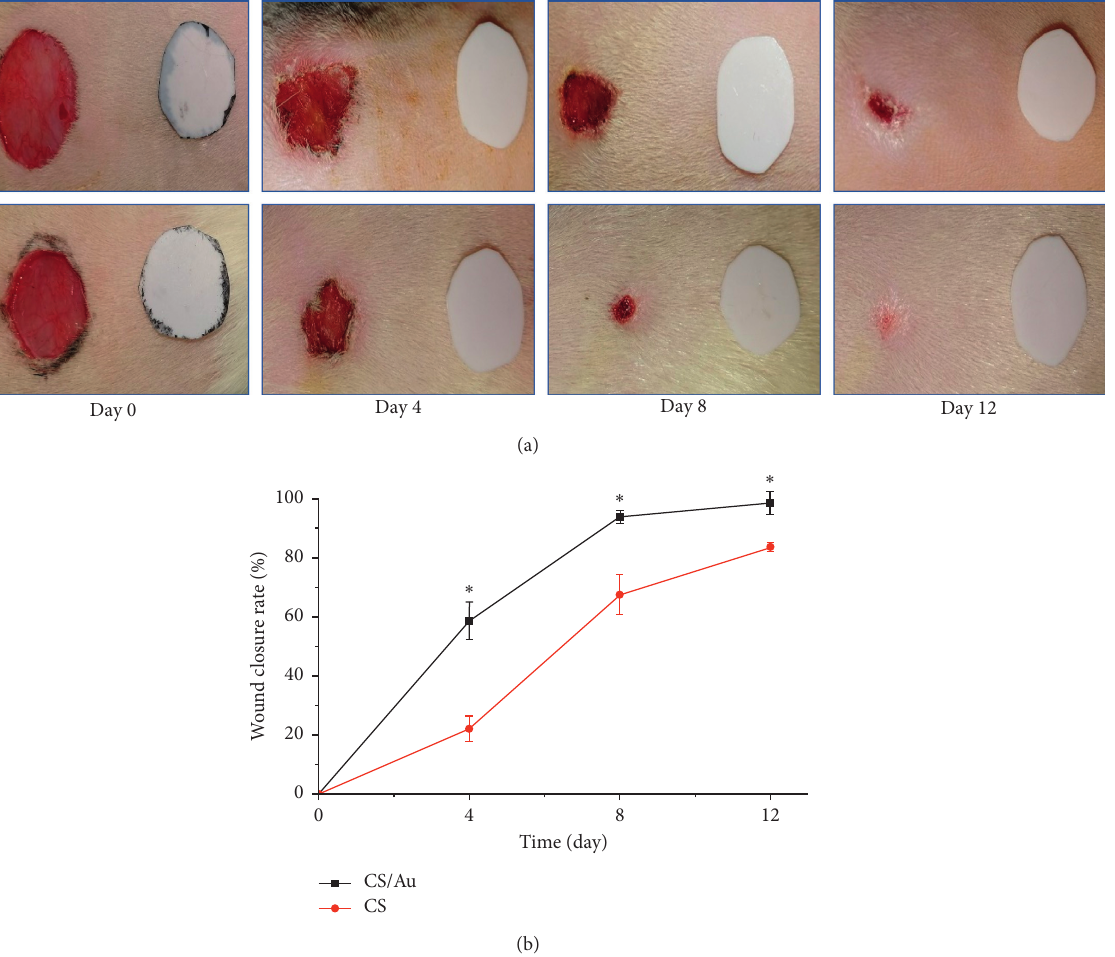
Figure 6: The differential effects of composites on wound healing. (a) Representative macroscopic appearance of wounds; CS (a1), CS/ AuNPs (a2); (b) wound-healing curves. ∗ Error bars represent the mean ± SD ( n � 3; ∗ statistically significant difference, ∗ P < 0 .